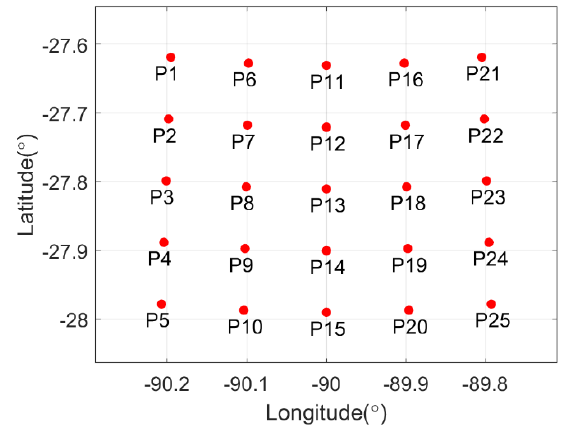
Figure 18. The fitting errors of the sixth-order Taylor expansion with 2000 s observation time at different orbit positions.